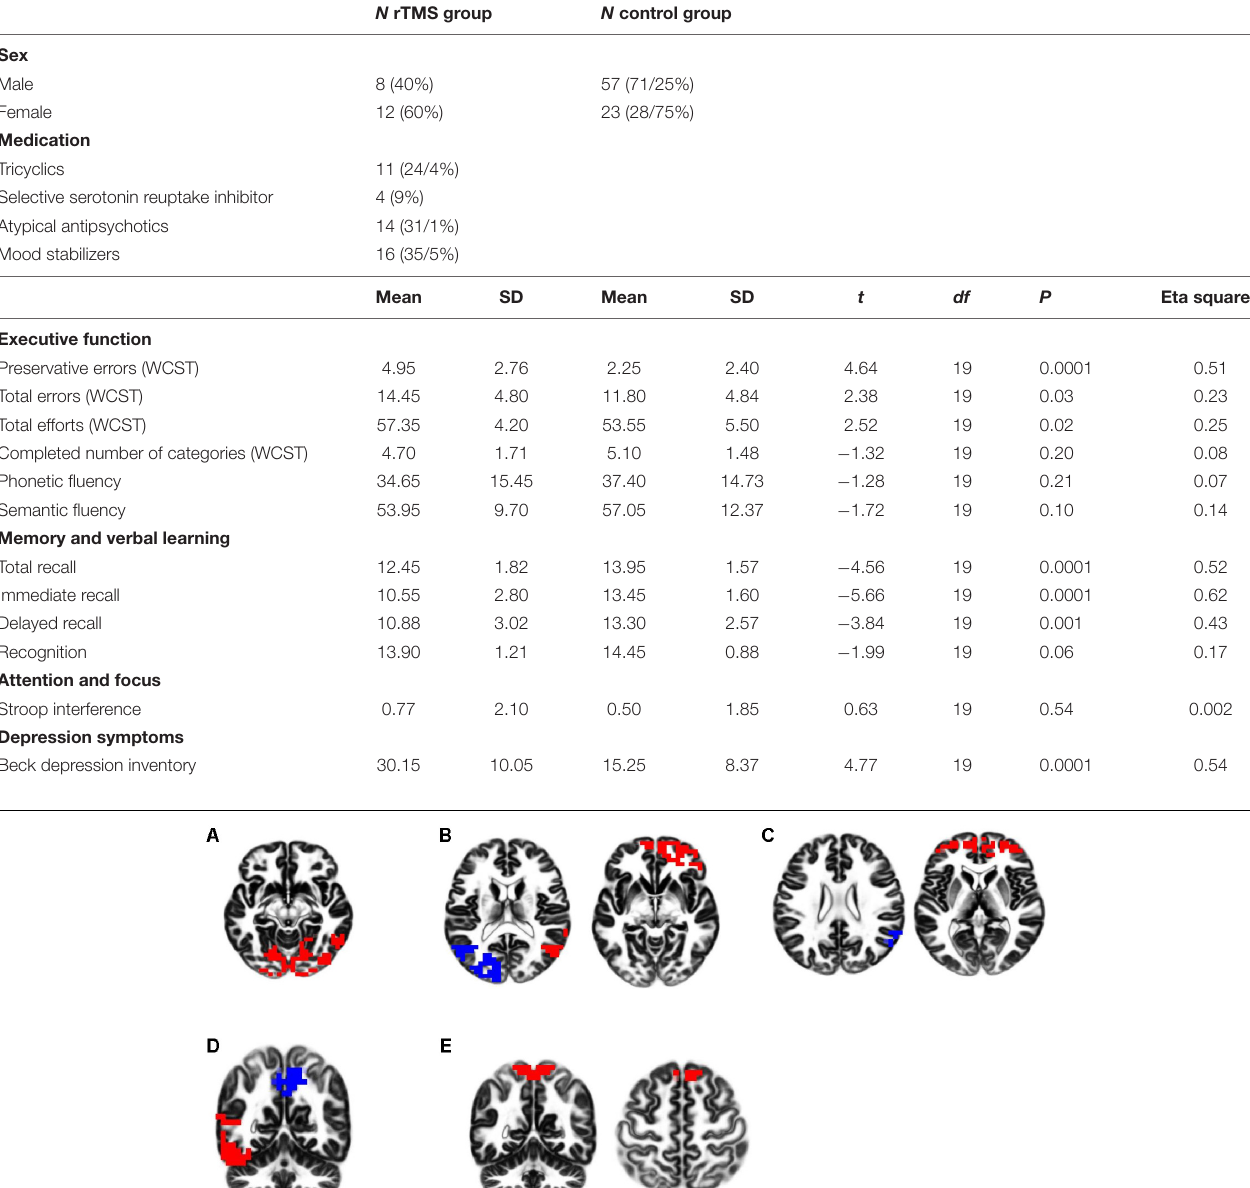
4 (IC-4): the visual network in alpha frequency band; (2) IC-5: dual-process visual perception network, characterized by a negative correlation between the right ventral visual pathway